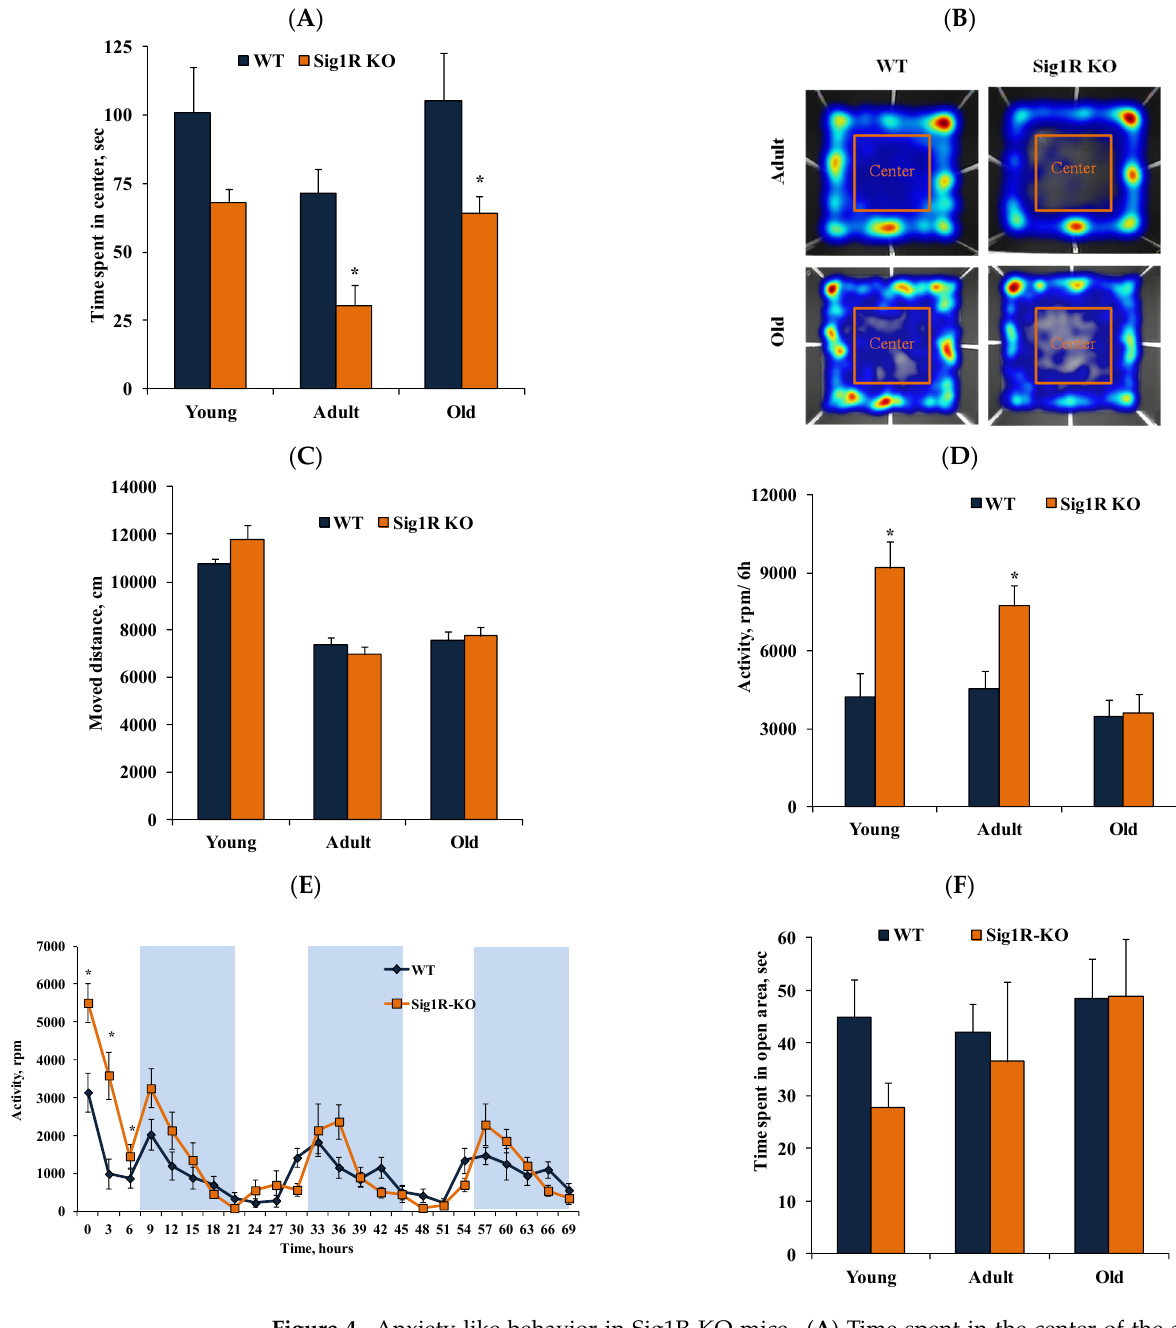
Figure 4. Anxiety-like behavior in Sig1R KO mice. ( A ) Time spent in the center of the arena of young (2 months), adult (5 months), and old (13 months) WT and Sig1R KO mice was measured using the open-field test ( n = 6–10 mice/group; two-way ANOVA followed by the Sidak test). ( B ) Representative image of moved paths during the open-field test. ( C ) The movement distances of young (2 months), adult (5 months), and old (13 months) WT and Sig1R KO mice were measured using the open-field test ( n = 6–10 mice/group). ( D ) Voluntary activity in the running wheel during the first 6 h of the 72-h trial of young (2 months), adult (4 months), and old (14 months) WT and Sig1R KO mice ( n = 6–9 mice/group; two-way ANOVA followed by the Sidak test). ( E ) Representative curve of 72 h voluntary activity of young (2 months) mice in the running wheel (shaded area indicates dark hours, 08:00–20:00) of metabolic cages. ( F ) Time spent in the open area by young (2 months), adult (6 months), and old (17 months) WT and Sig1R KO mice was measured using the zero-maze test ( n = 6–15 mice/group). Data are shown as the mean ± SEM (* p < 0.05 vs. WT).